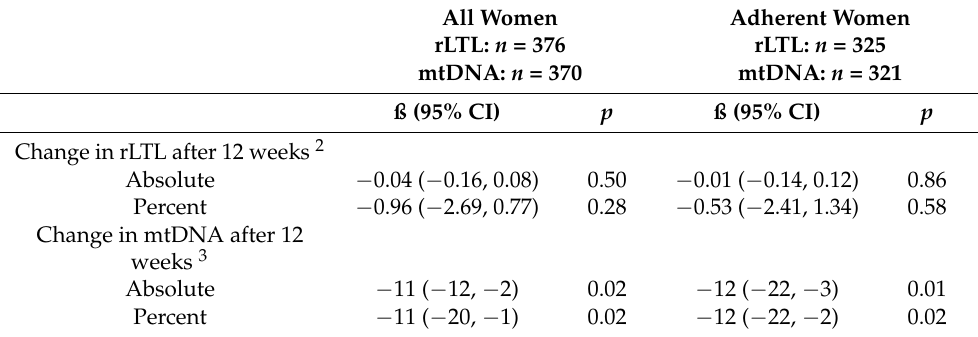
Table 4. Adjusted effect of iron supplementation on change in rLTL and mtDNA content after 12 weeks 1